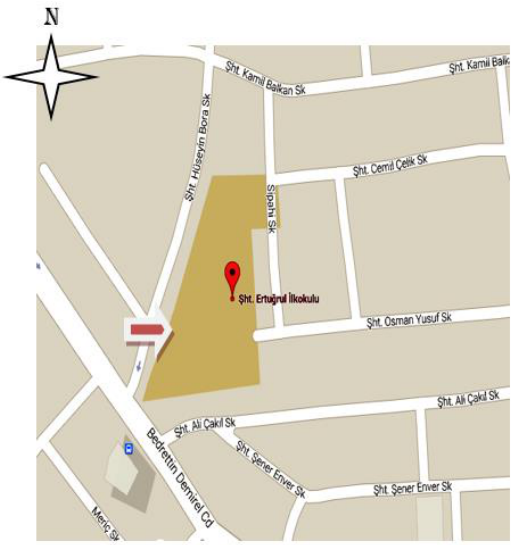
Figure 9. The location of Şehit Ertuğrul Ilkokulu (Source: Google map).